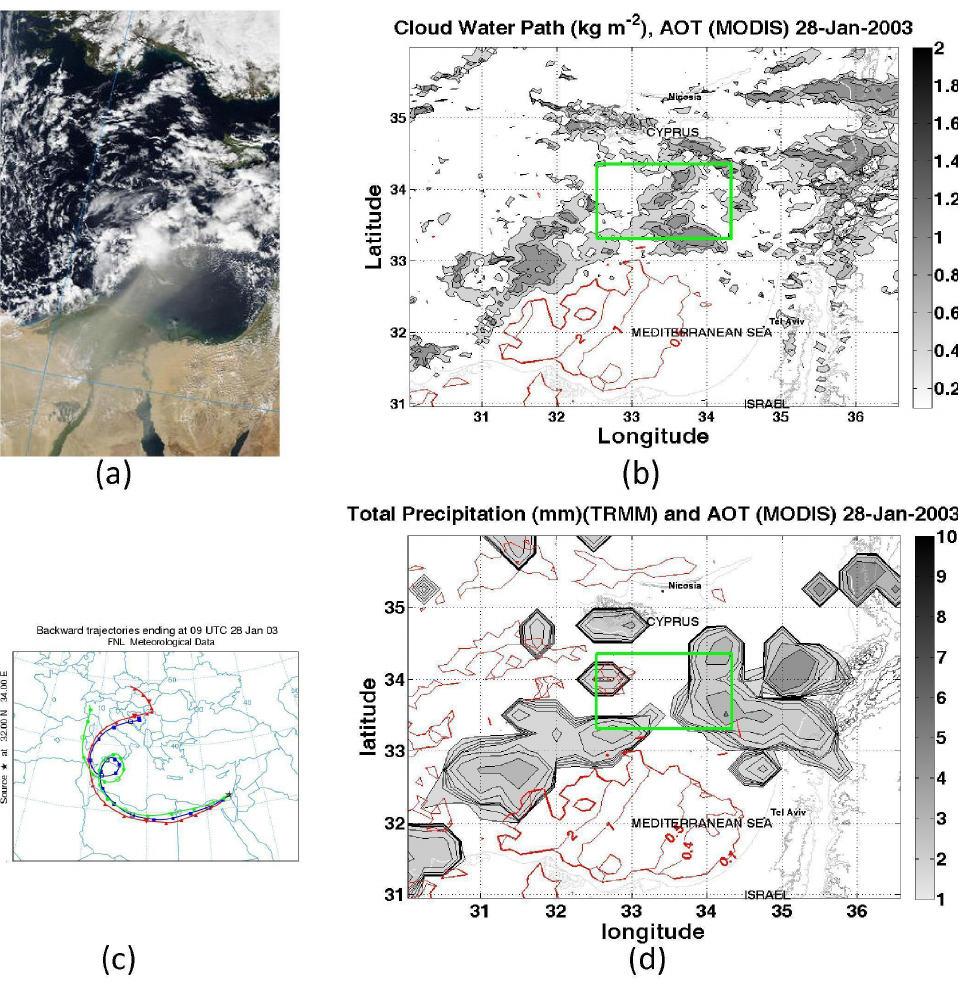
Fig. 1. General description of the case study – dust storm of 28 January 2003 above the East Mediterranean sea. (a) MODIS image (Aqua satellite) at 11:00UT, (b) Cloud Water Path (shaded area, in kg m − 2 ) and Aerosol Optical Thickness (AOT, red contours) retrieved from the MODIS observation, (c) Back trajectory analysis from the HYSPLIT model, (d) Total precipitation (in mm) between 06:00 and 12:00UT measured by the TRMM instrument together with MODIS AOT in red contours. The thick green rectangle in (b) and (d) show the region for which detailed cloud simulations were carried